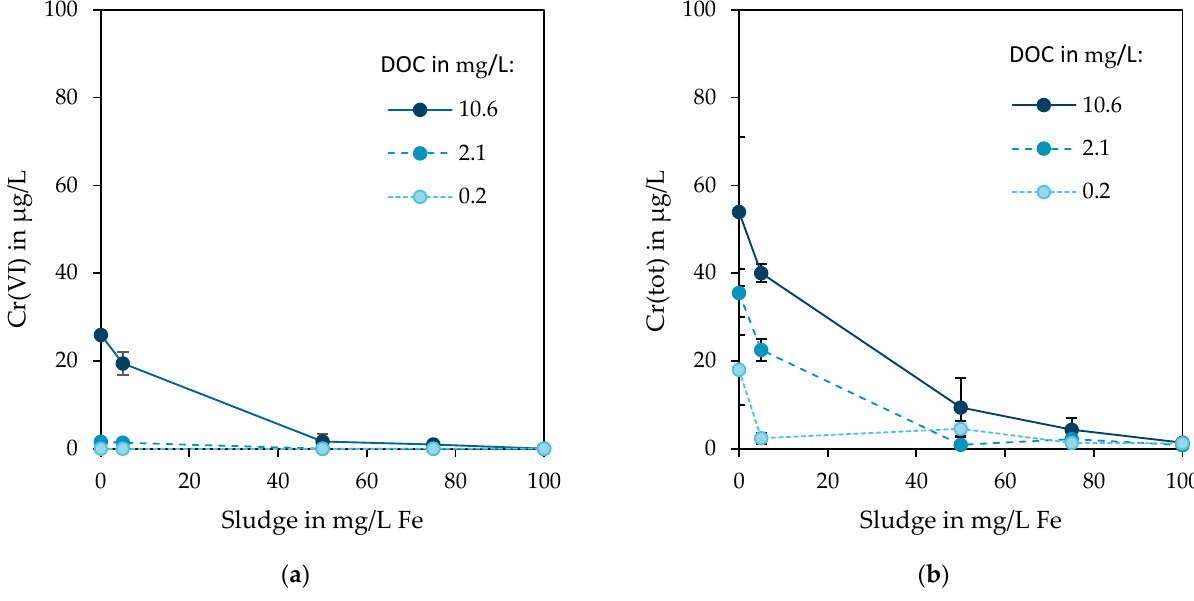
Figure 4. Mean residual concentrations of ( a ) Cr(VI) and ( b ) Cr(tot), in batch tests with increasing dosages of pre-formed sludge from FeSO 4 and a fixed dose of fresh Fe(II) at different DOC concentrations (HA). Test conditions: 100 µg/L Cr(VI), 0–100 mg/L Fe(III), 1.0 mg/L Fe(II), pH 7.5, 0.2–10.6 mg/L DOC, t = 60 min, n = 2; error bars indicate minimum and maximum.